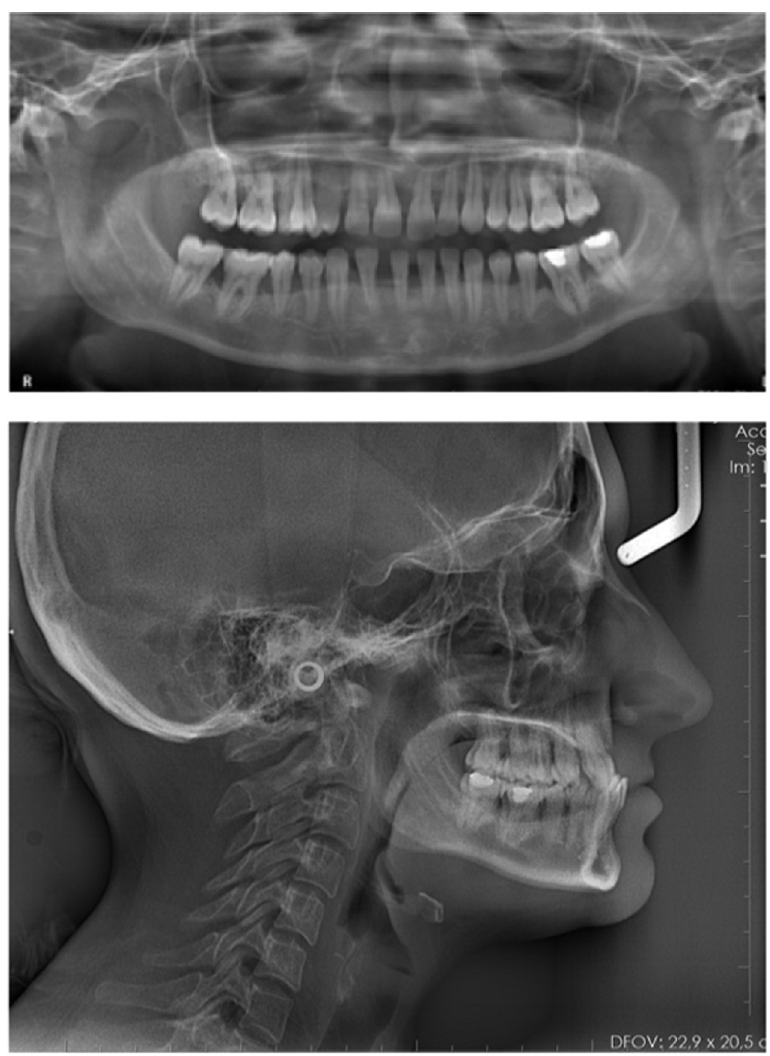
Figure 3. Pretreatment panoramic X-ray and lateral cephalogram.